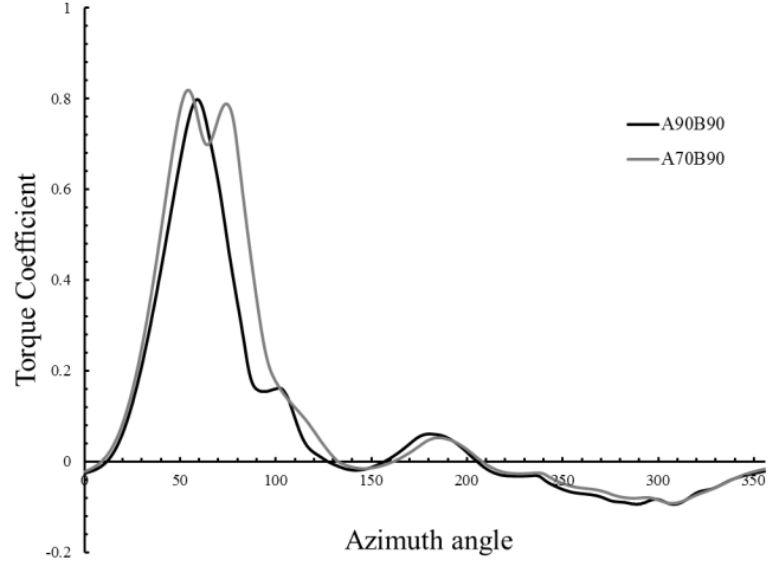
Figure 14. Torque coefficient of a single blade.